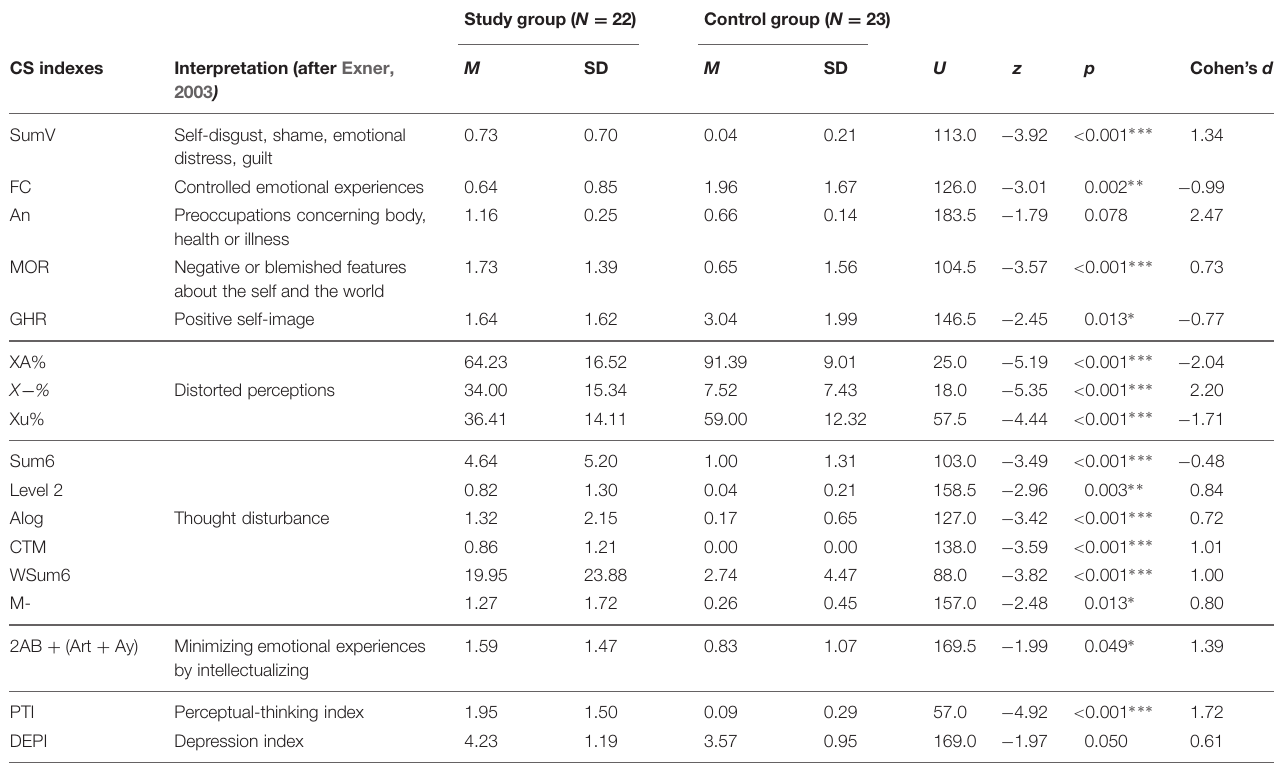
TABLE 4 | Mann–Whitney U test comparing continuous variables in the Rorschach Comprehensive System (CS) between children with and without a parent suffering from ALS. Study group ( N = 22) Control group ( N = 23)